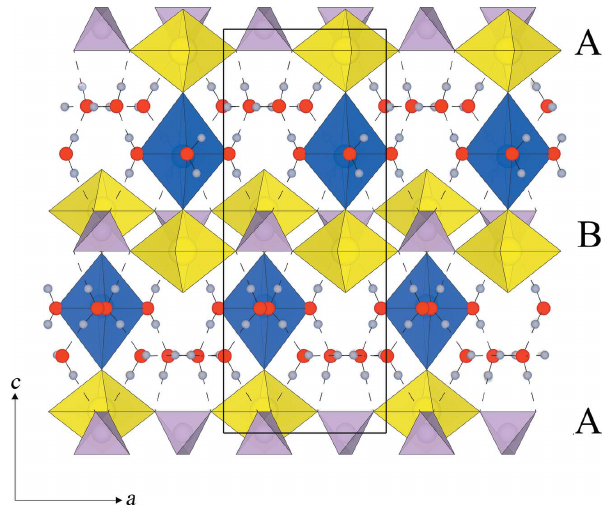
Figure 5 An ac projection of the structural model of metatorbernite showing the ABAB stacking arrangement of autunite sheets. Uranyl polyehdra are shown in yellow, phosphate tetrahedra in lilac and copper octahdra in blue; oxygen atoms are displayed as red spheres and hydrogen as light grey spheres. Hydrogen bonds are displayed as dashed